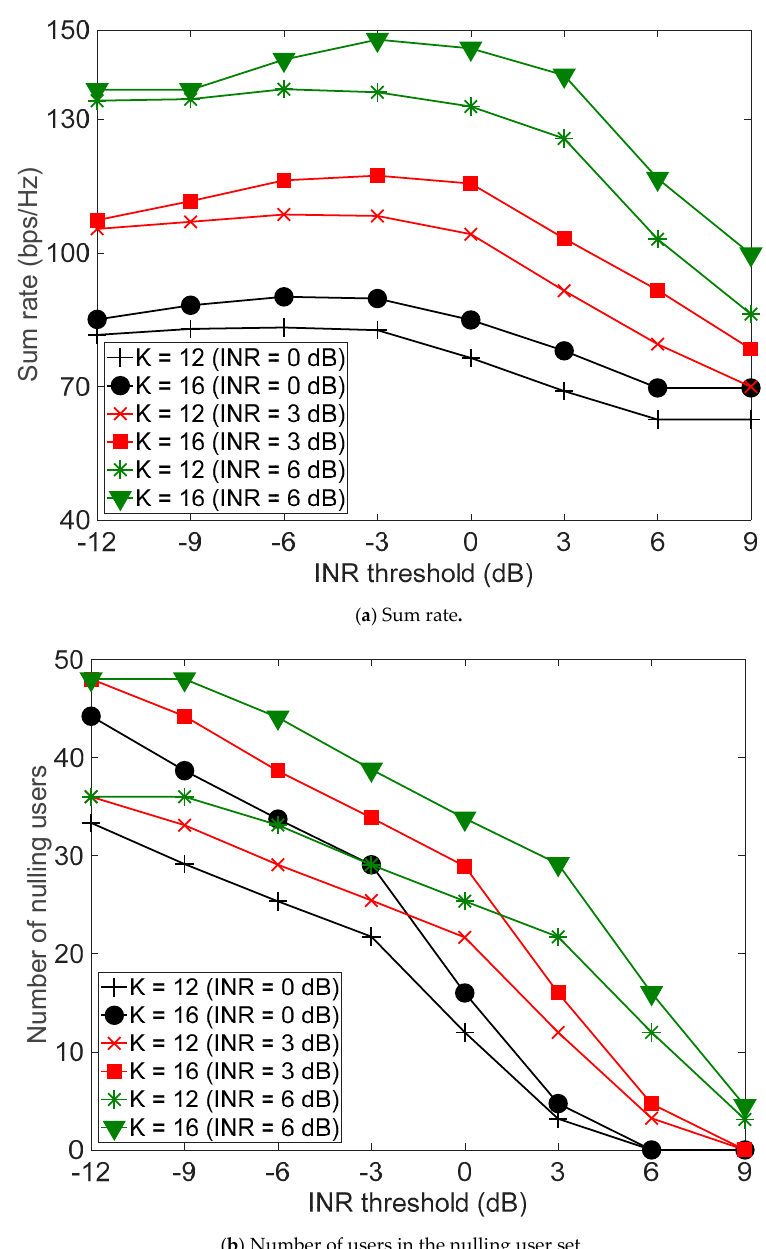
Figure 3. Performance of multi-user parameterized beamforming (MUPB) according to δ th